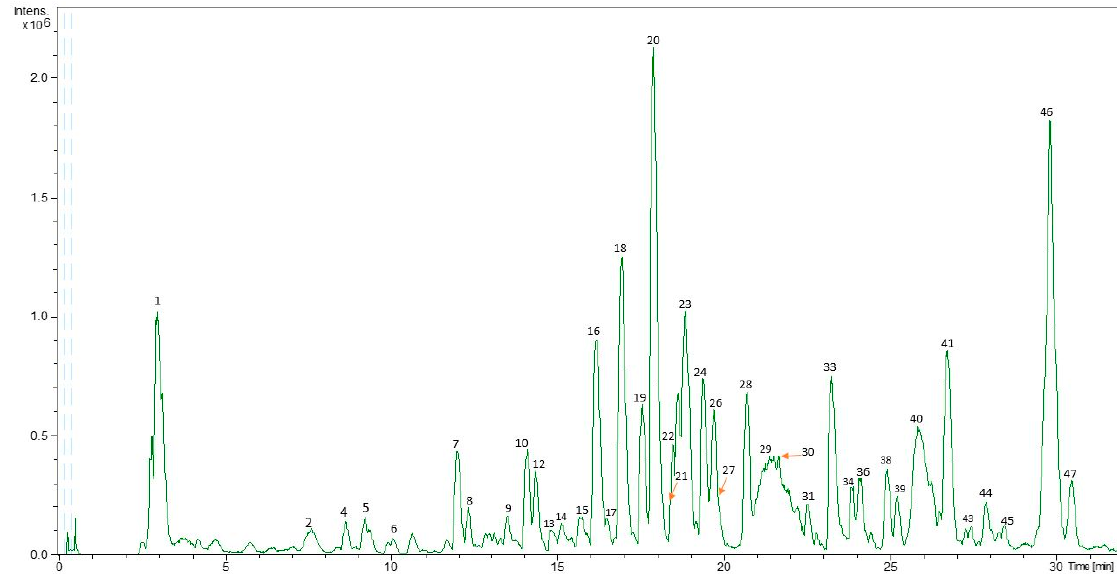
Figure 1. Base peak chromatogram (BPC) of representative pressurized liquid extraction (PLE) extract obtained by high-performance liquid chromatography coupled to electrospray ionization time-of-flight mass spectrometry (HPLC-ESI-TOF-MS). Table 2. Phenolic and other polar compounds of C. grandis PLE extracts characterized by HPLC-ESI-TOF-MS.